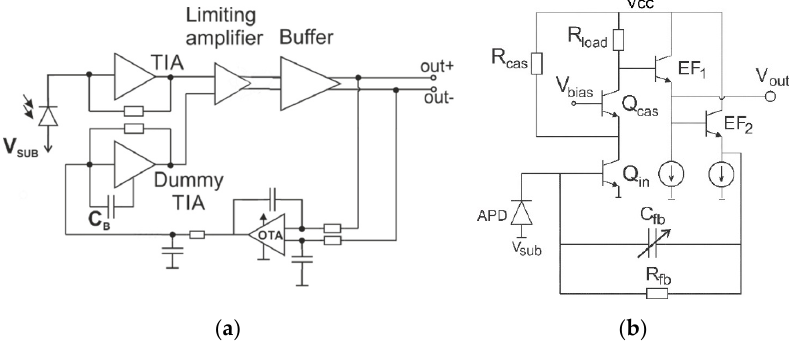
BiCMOS OEIC for BER = 10 − 9 were − 33 dBm at 1 Gb/s and − 29.3 dBm at 2 Gb/s [30]. It